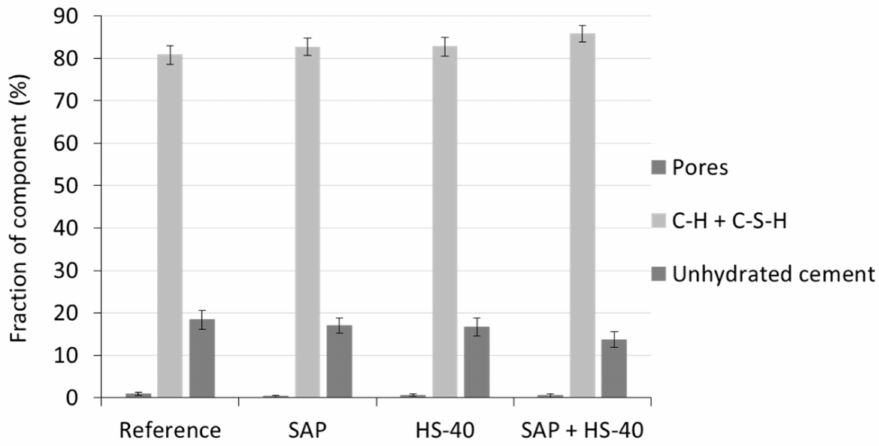
Figure 10. Fraction of pores, hydration products and unhydrated cement of cement pastes, determined from SEM-BSE